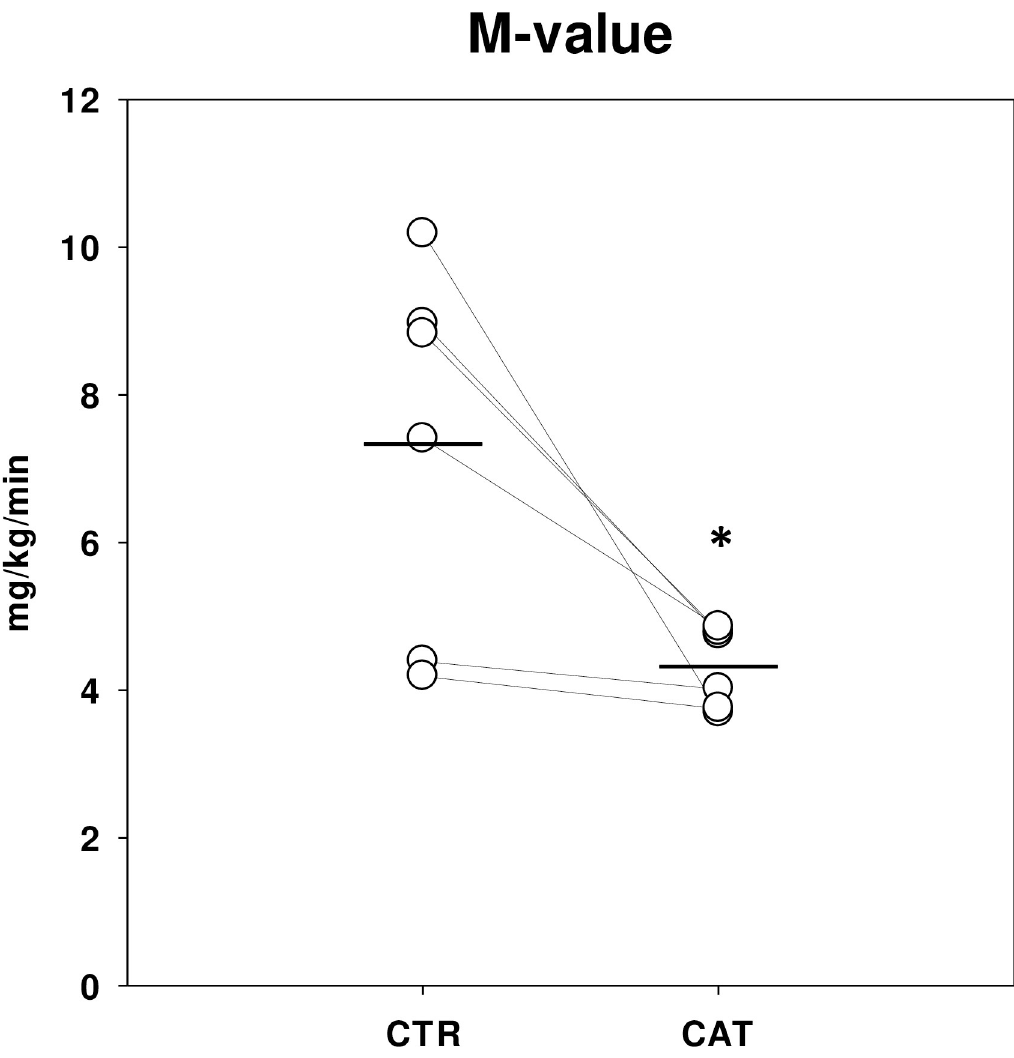
Fig 3. Hyperinsulinemic euglycemic clamp. M-value (mg/kg/min) for CTR (overnight fast) and CAT (Inflammation + 36 hour bed rest and fast) are depicted with paired individual data points (white dots connected by a straight line) and means (horizontal lines). Analysed with paired t-test, p-values < 0.05 were considered significant ( � ). N = 6.